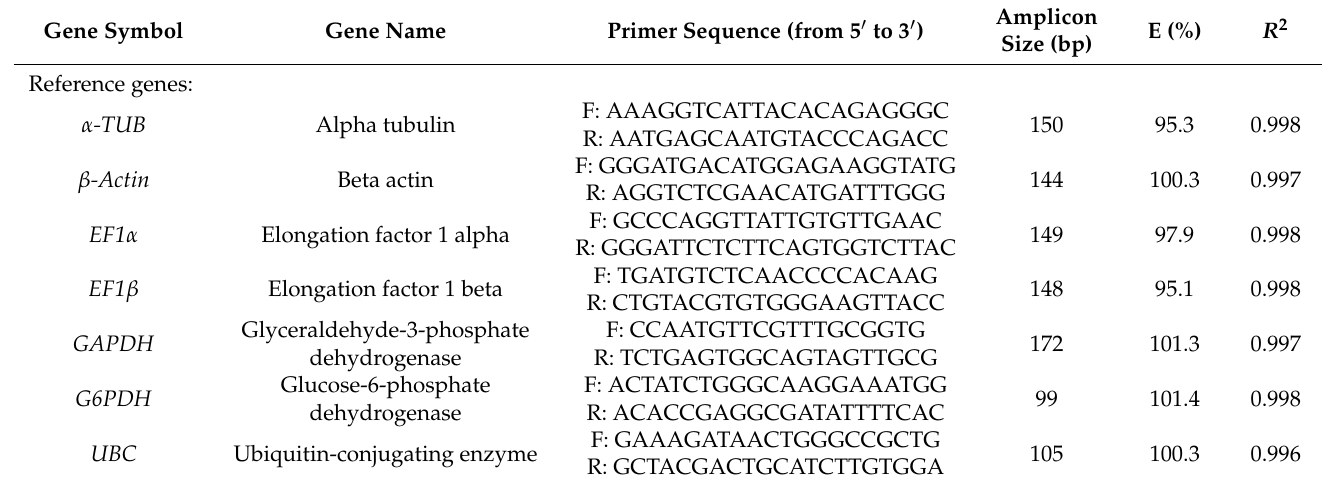
Table 1. Primer sequences and amplification sizes of the selected RGs and target